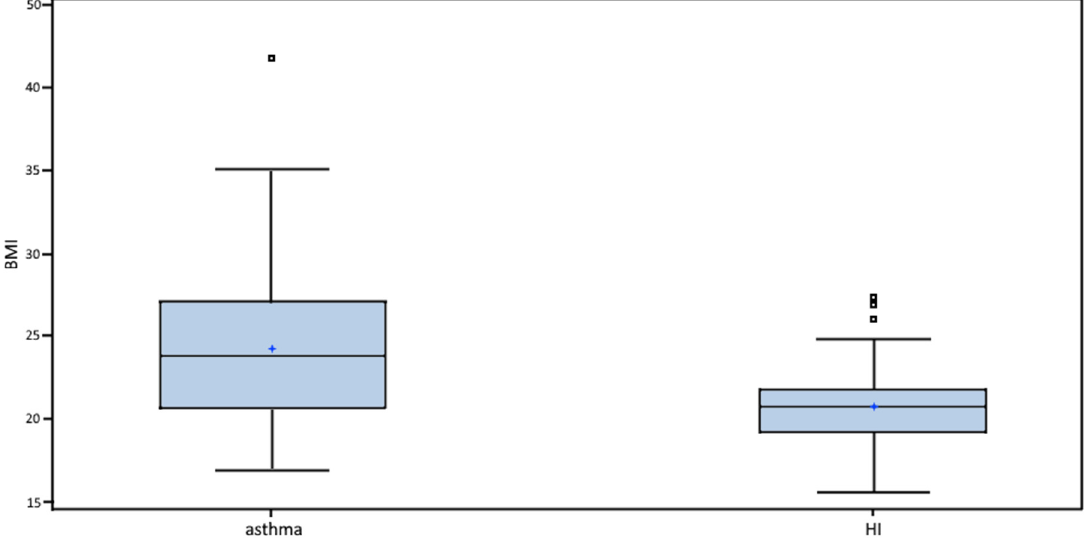
Figure 1. BMI in asthmatics vs. HI. Boxes indicate the inter-quartile range. Horizontal lines within boxes indicate medians. Whiskers extend to the highest or lowest values. BMI: body mass index; HI: healthy individuals .